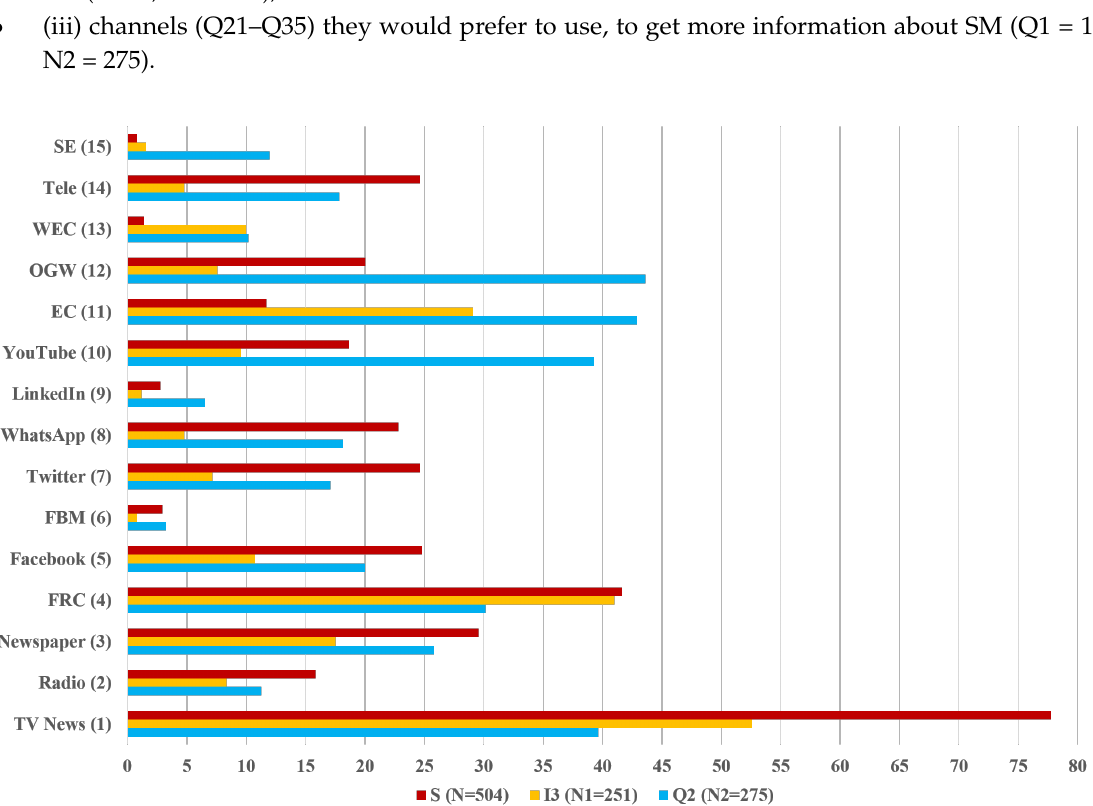
Figure 5. Sources of information regarding electricity (S), regarding SM (I3) and sources on which users would like to search for more information regarding SM (Q2). Note: S1–S15 correspond to the blue bars 1–15 respectively, I31–I45 correspond to yellow bars 1–15 respectively and Q21–Q35 correspond to red bars 1–15 respectively. (FRC: Friends, Relatives, Colleagues, FBM: Facebook Messenger, EC: